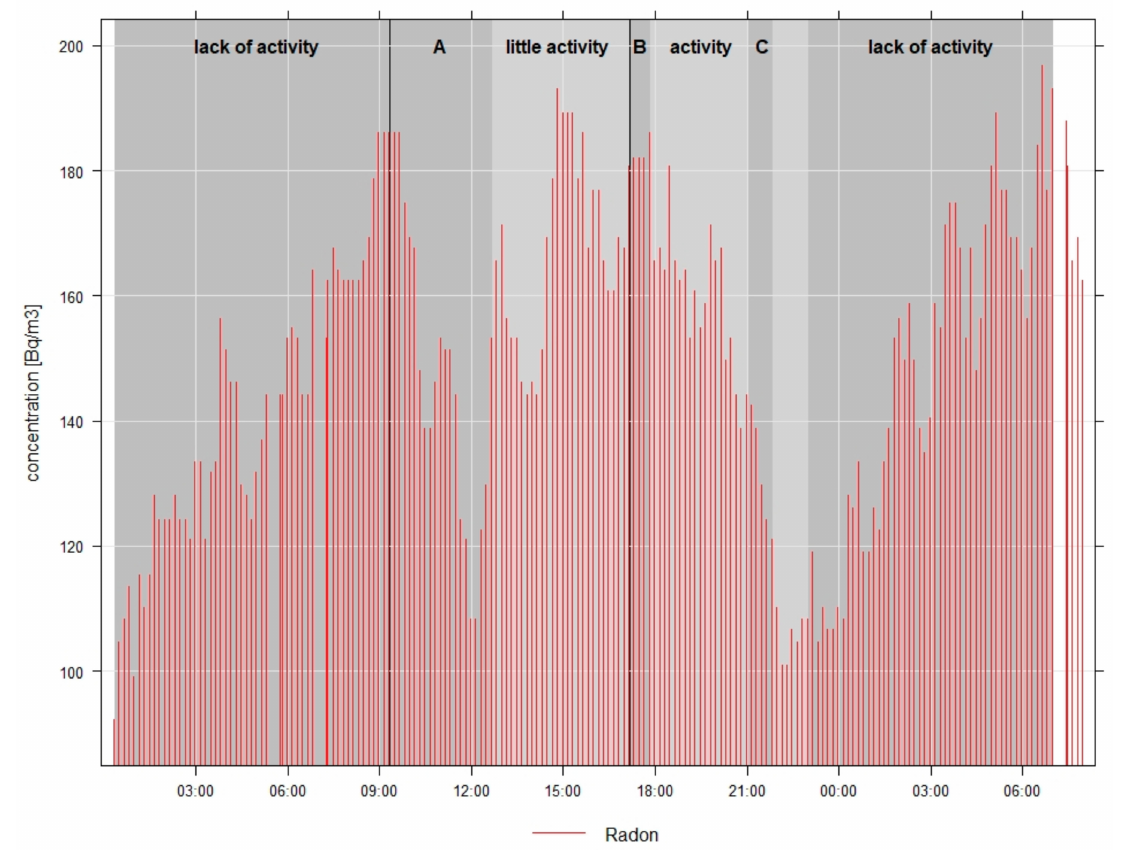
Figure 6. User influence on the radon concentration in building B1—day 08 March 2022–9 March